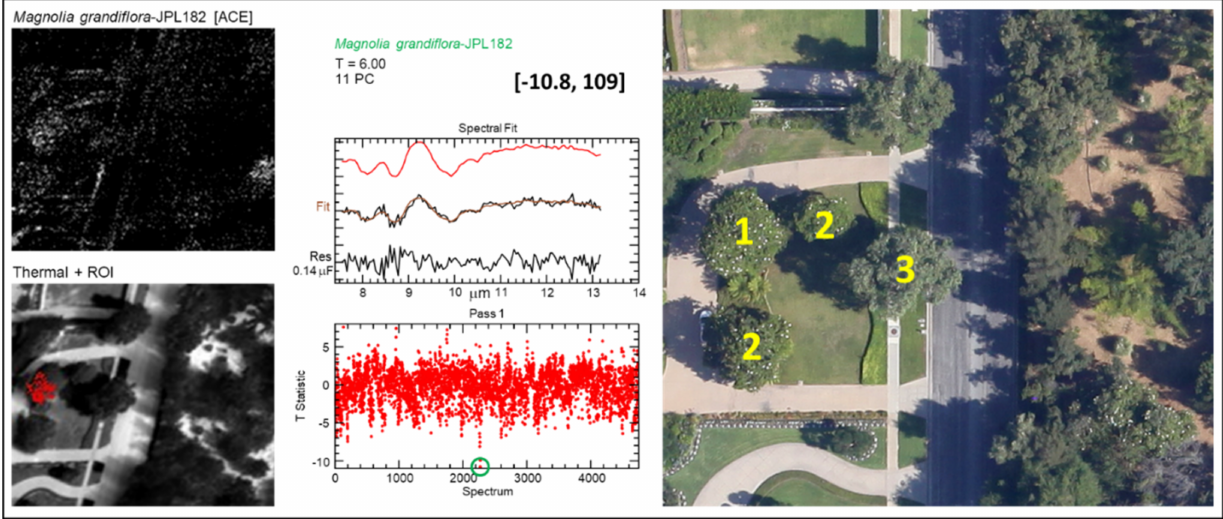
Figure 22. Rare positive ID of a Magnolia grandiflora (1). Two additional neighboring M. grandiflora (2) remain undetected. Included in the scene is a correctly ID’d Quercus lobata